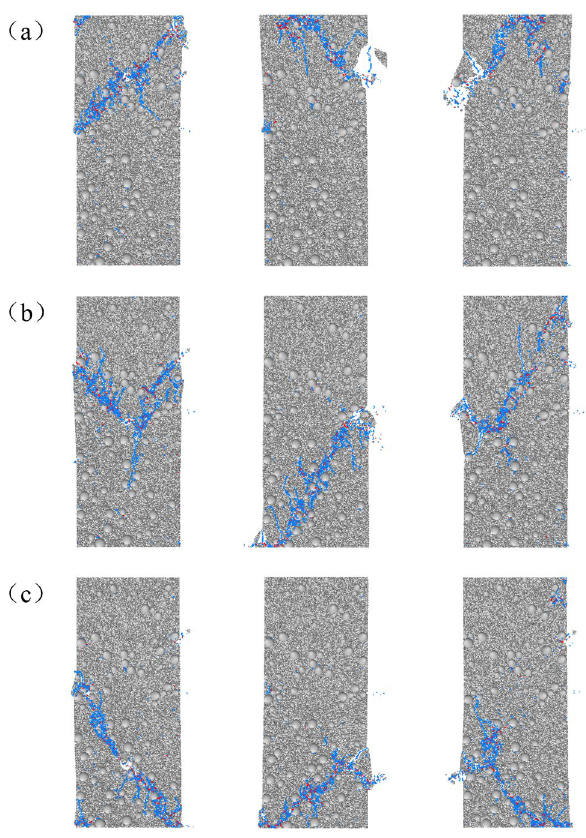
Figure 12. Failure modes of specimens at different defect locations.